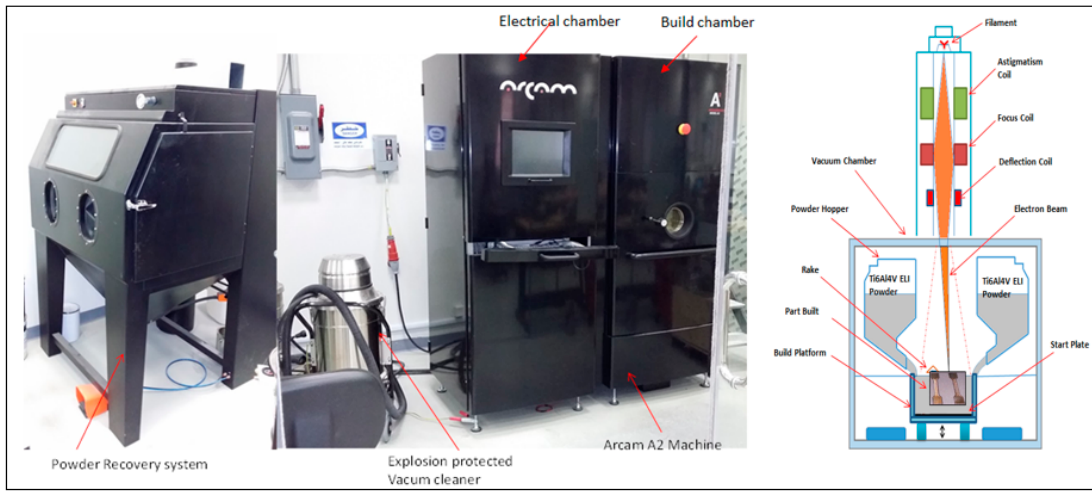
Figure 10. ARCAM A 2 set up and schematics of EBM.